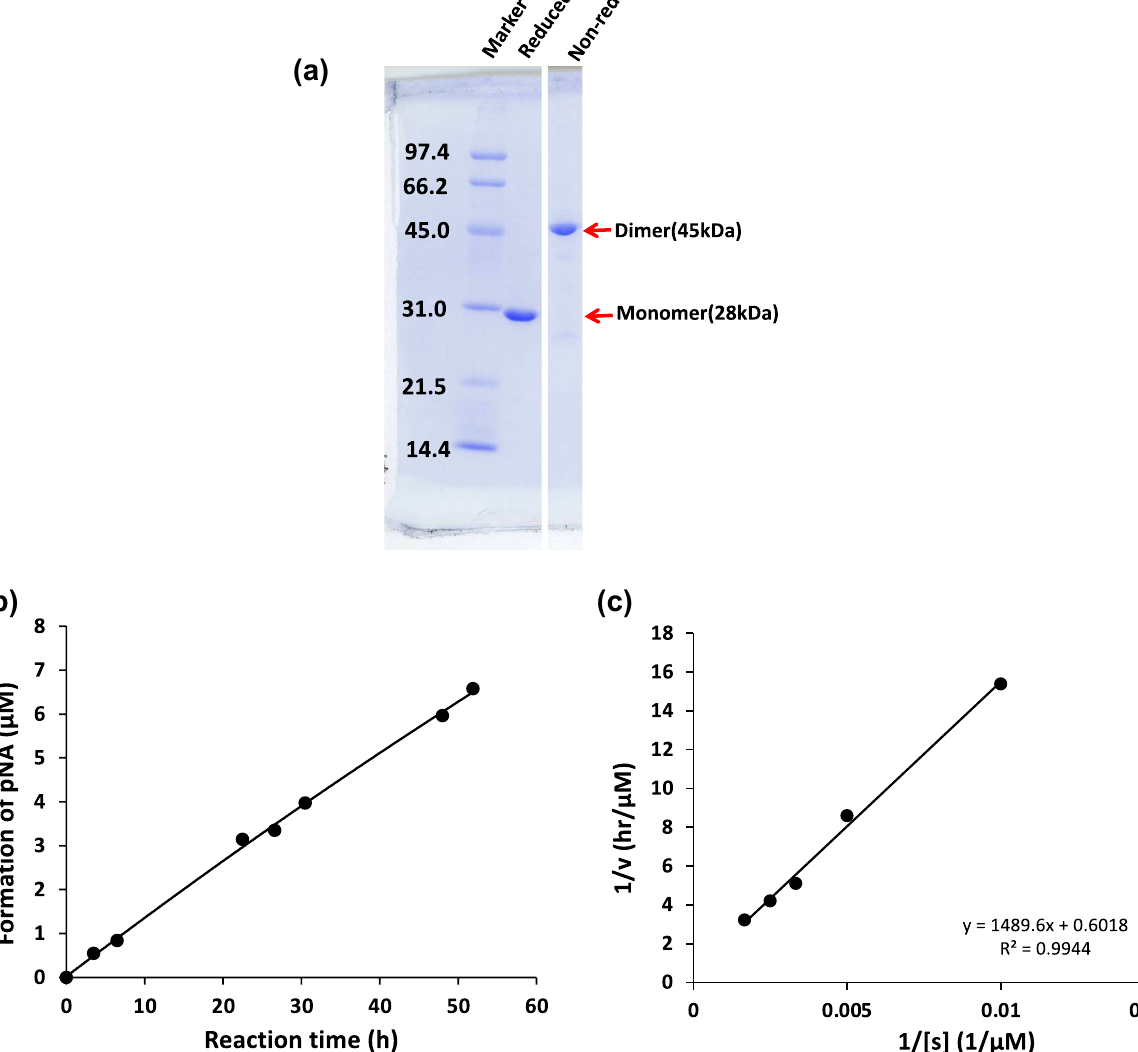
Figure 3. ( a ) Results of SDS-PAGE analysis for H34wt: SDS-PAGE analysis (12% gel) for H34wt after a size- exclusion chromatography is shown. A band of dimer at approximately 45 kDa is observed under the non- reduced condition. Under the reduced condition, only a single band of approximately 28 kDa is detected, which corresponds to the monomer. Bands other than the monomer of the light chains are essentially absent under either reduced or non-reduced condition. ( b ) Time course of the cleavage of the synthetic substrate Arg-pNA by H34wt. Reaction conditions: H34wt: 10 μM. Arg ‐ pNA: 200 μM. Reaction temperature: 37 °C.